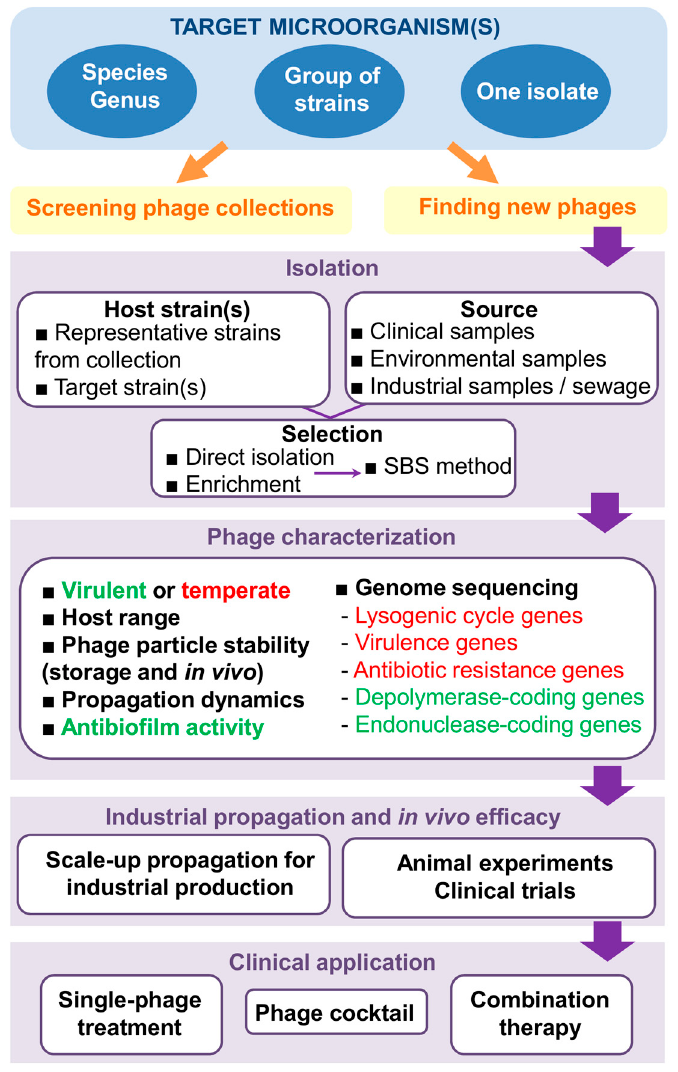
Figure 1. Steps involved in the development of phage therapy strategies. In the phage characterization step, text in green and red respectively correspond to desirable and undesirable characteristics in a phage for therapeutic applications. Abbreviations: SBS method, step-by-step method.